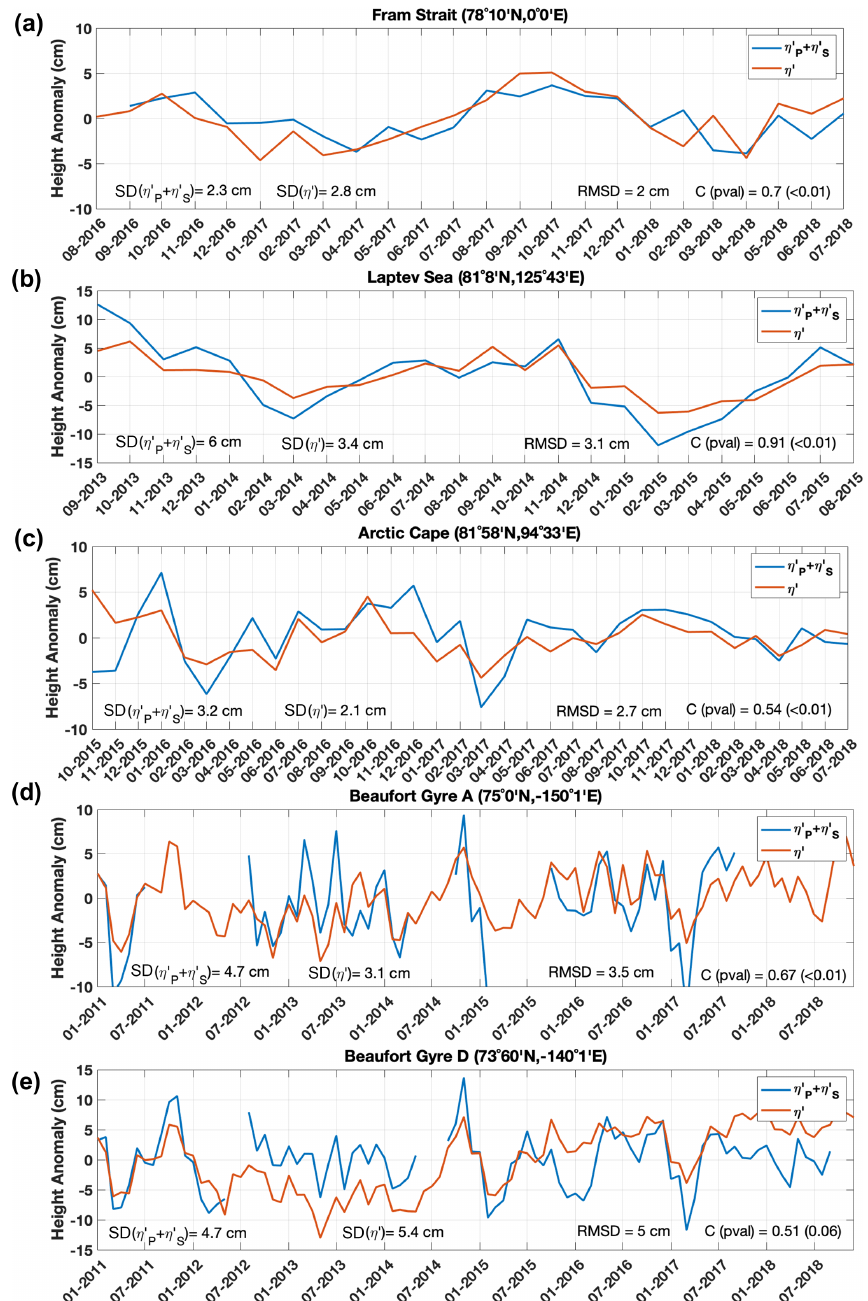
+ η (cid:48) ) derived from data at moorings (a) FS_S, (b) AC, (c) M1_4p6, (d) A and (e) D (blue line) is Figure 9. The sea level anomaly ( η (cid:48) P S displayed against the η (cid:48) interpolated at the mooring location (red line). Standard deviations of η (cid:48) and η (cid:48) left corner and the RMSD and correlation coefficient in the bottom right corner (Pearson’s correlation coefficient, where the p value was computed using the effective number of degrees of freedom, Emery and Thomson,